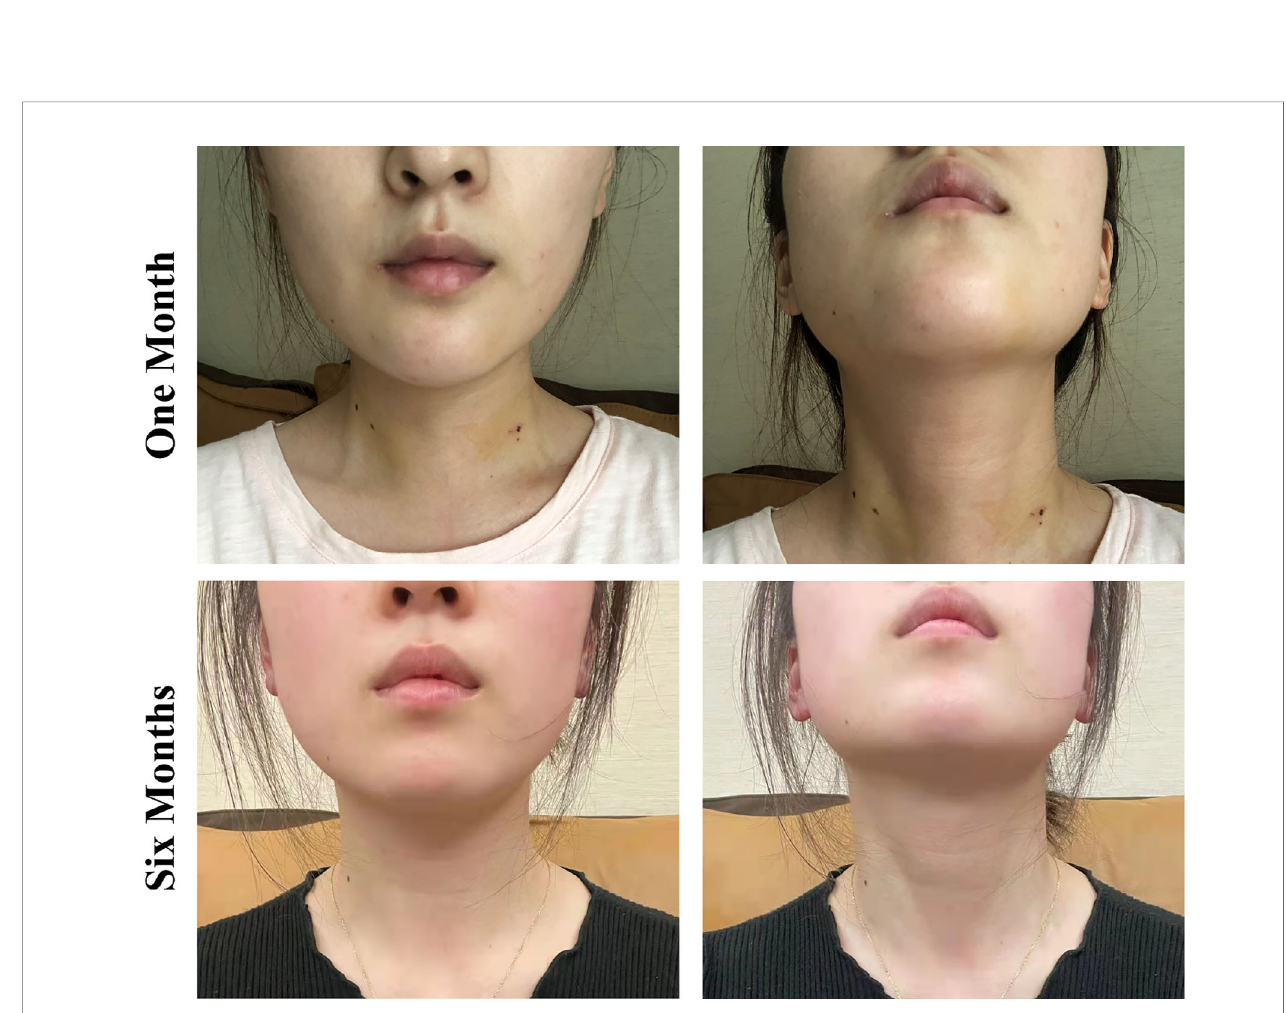
FIGURE 4 | Cosmetic results 1 month and 6 months postoperatively of